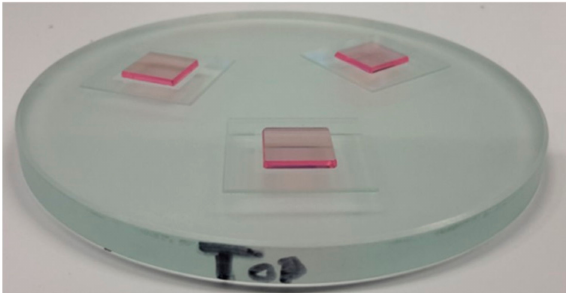
Figure 3. Photographs of three assemblies, each consisting of a KY(WO 4 ) 2 sample bonded with ultraviolet (UV)-curable adhesive onto a MEMpax substrate and wax mounted onto an ultra-parallel supporting glass plate for thinning and